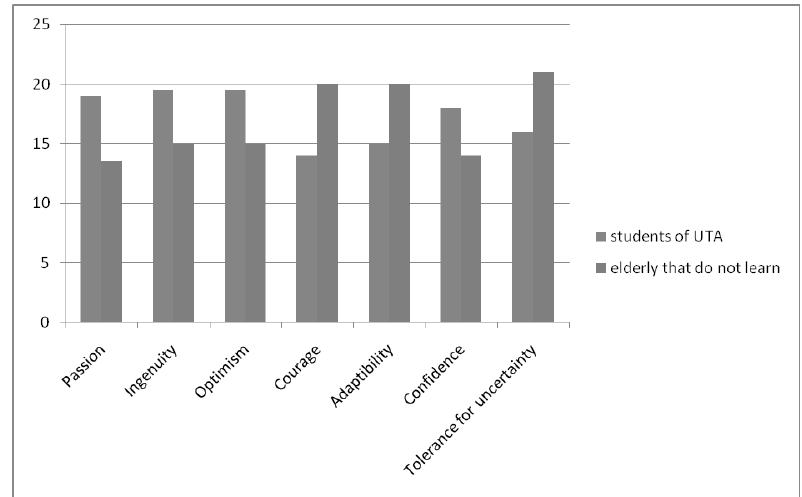
Fig. 2.3. A comparison between group of students of the University and the Third Age and group of elderly persons who are not enrolled in the features detection of tolerance for uncertainty. Source: Authors’